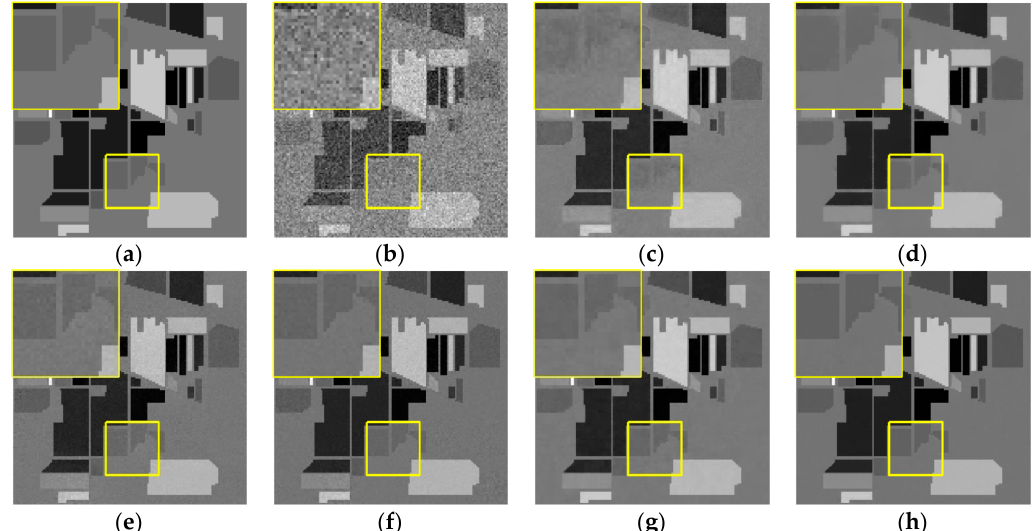
Figure 3. Denoised results of the 11th band by di ff erent methods when the variance is 20: ( a ) original, ( b ) noisy, ( c ) HyRes, ( d ) total variation-regularized low-rank matrix factorization (LRTV), ( e ) low-rank matrix recovery (LRMR), ( f ) noise-adjusted iterative low-rank matrix approximation (NAILRMA), ( g ) total variation regularized low-rank tensor decomposition (LRTDTV), ( h ) and proposed.